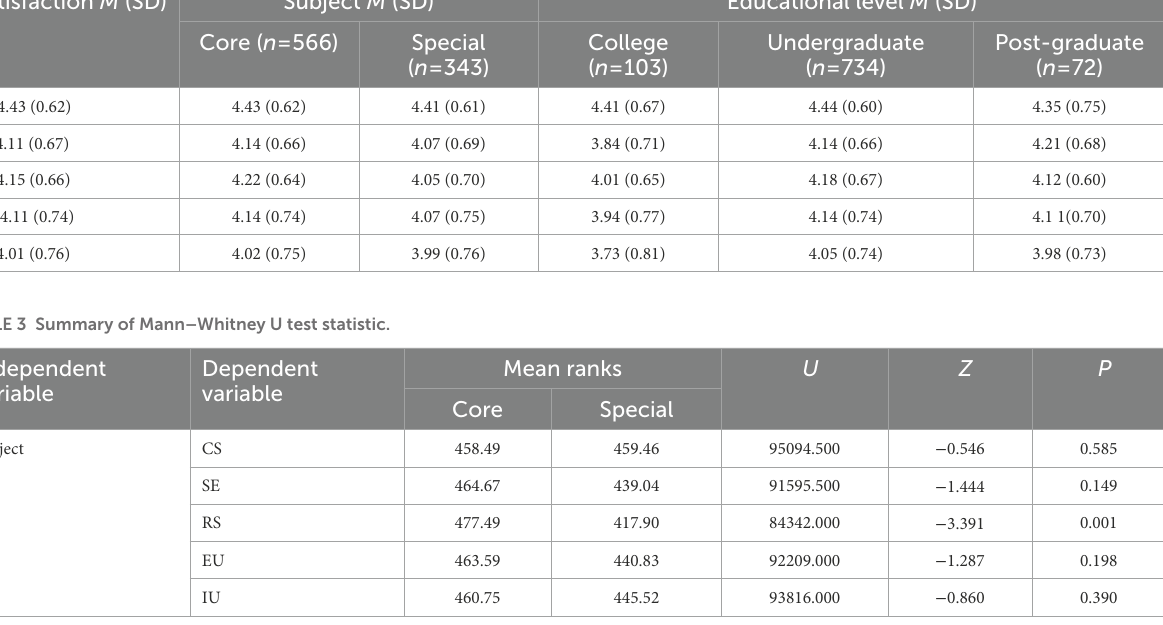
TABLE 2 Overall satisfaction of teachers of different subject and educational level. Satisfaction M (SD)